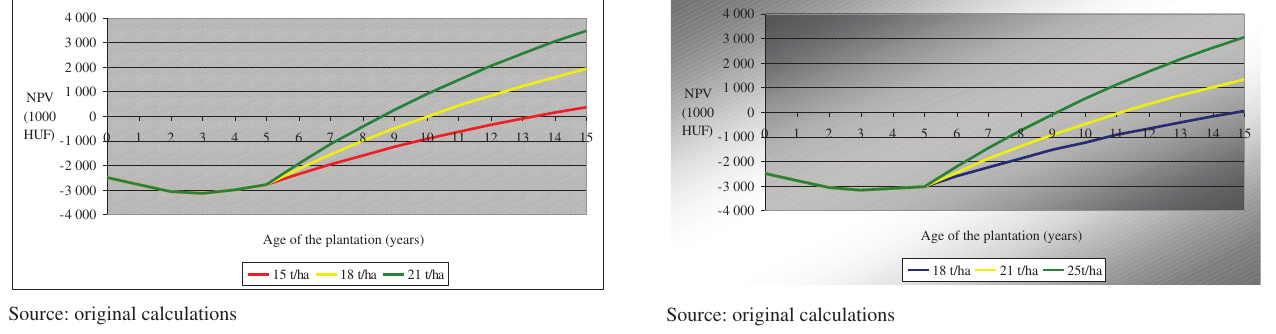
Figure 3 – Development of the economy of apricot growing as a function of yields at low producer’s prices (when prices are lower by 15% than the